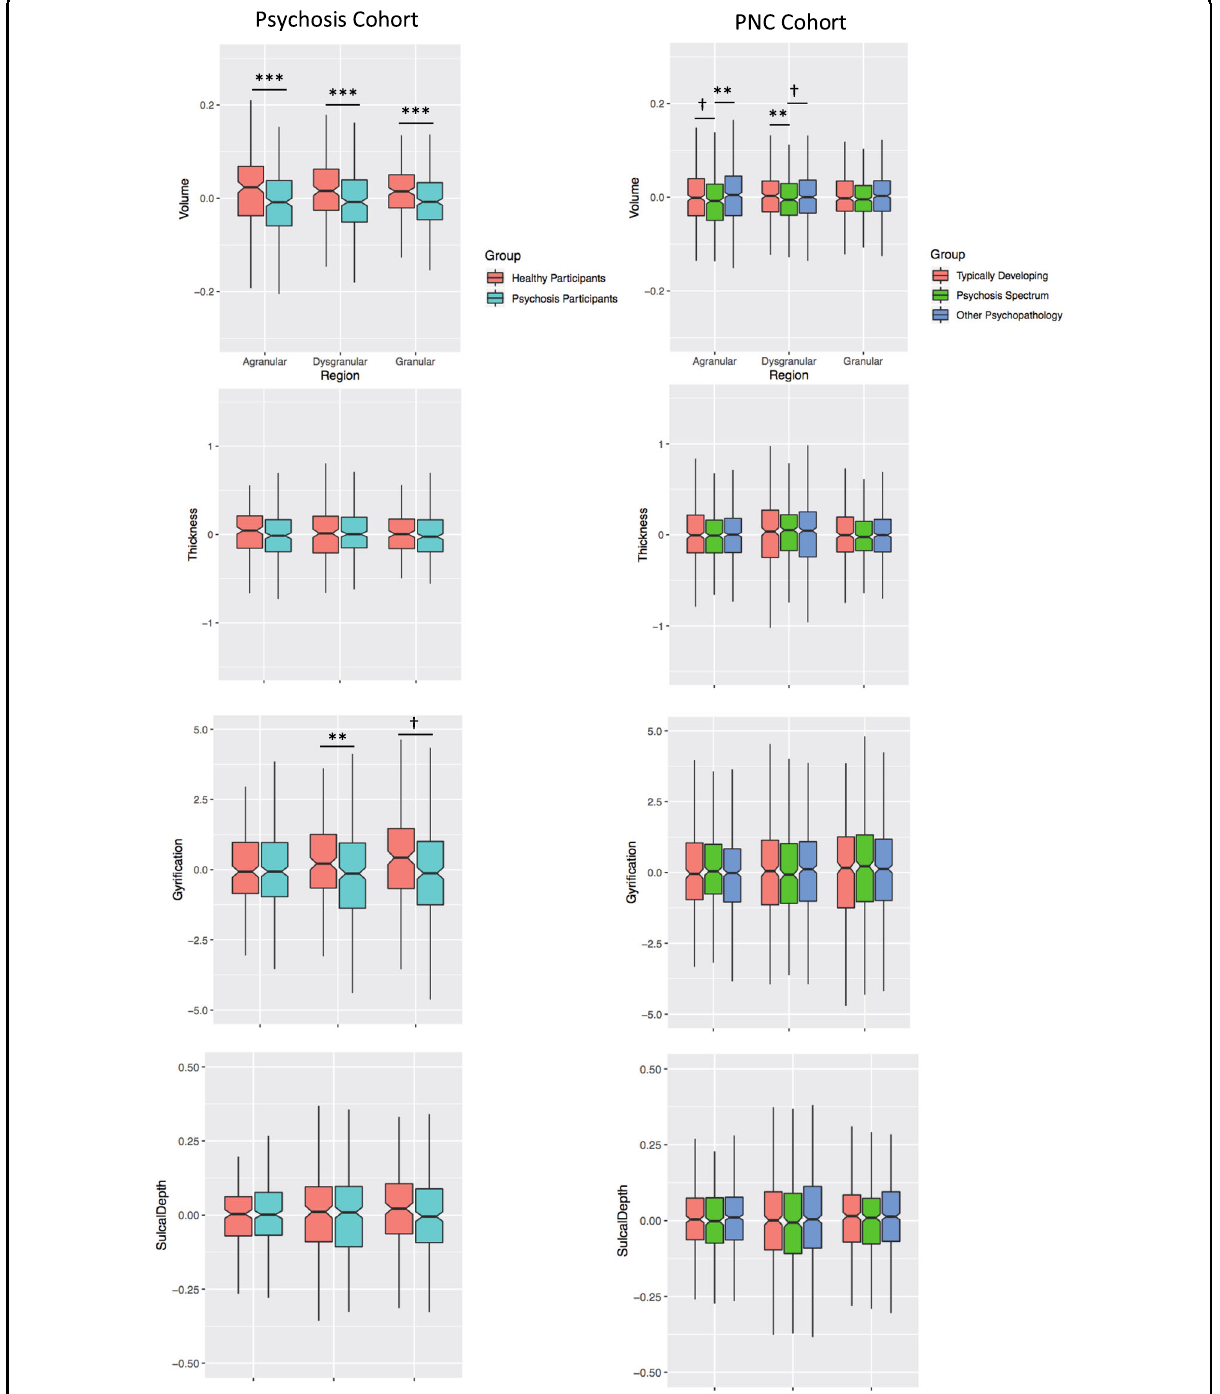
Fig. 1 Insula volume and surface-features based on region-of-interest analyses. Insula volume was extracted from granular sub-regions in all participants using masks from Farb and colleagues 64 . Psychotic disorder participants and psychosis-spectrum youth exhibited reduced volume of insula sub-regions, following an anterior-posterior gradient. Surface-based morphometry values were extracted from granular sub-regions based on parcellations from the HCP-MMPI atlas 66 . Signi fi cant alterations were observed only for dysgranular gyri fi cation within the psychotic disorders cohort. Marginal means are presented. Covariates included age, gender, total intracranial volume (TIV), study (for psychotic disorders cohort), and topography defects (for surface-based measures). *** p < 0.001, ** p < 0.017, † p < 0.05 but did not survive multiple comparisons